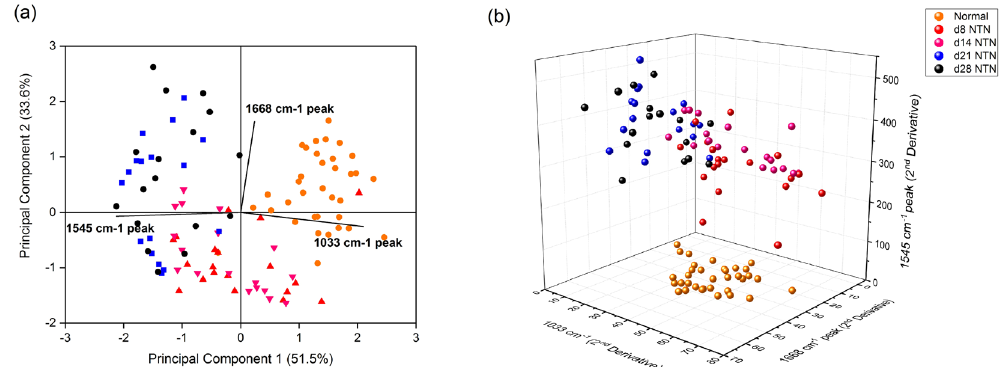
Figure 5. ( a ) The PCA biplot represents the locations of 2 nd derivative spectra of 107 urine samples and the correlations among the three potential urinary spectral markers (1668 cm − 1 , 1545 cm − 1 and 1033 cm − 1 bands) on the first two principal components (85.1% of total variance). (b) 3D scatter plot displayig the separation of normal, inflammatory and fibrotic NTN